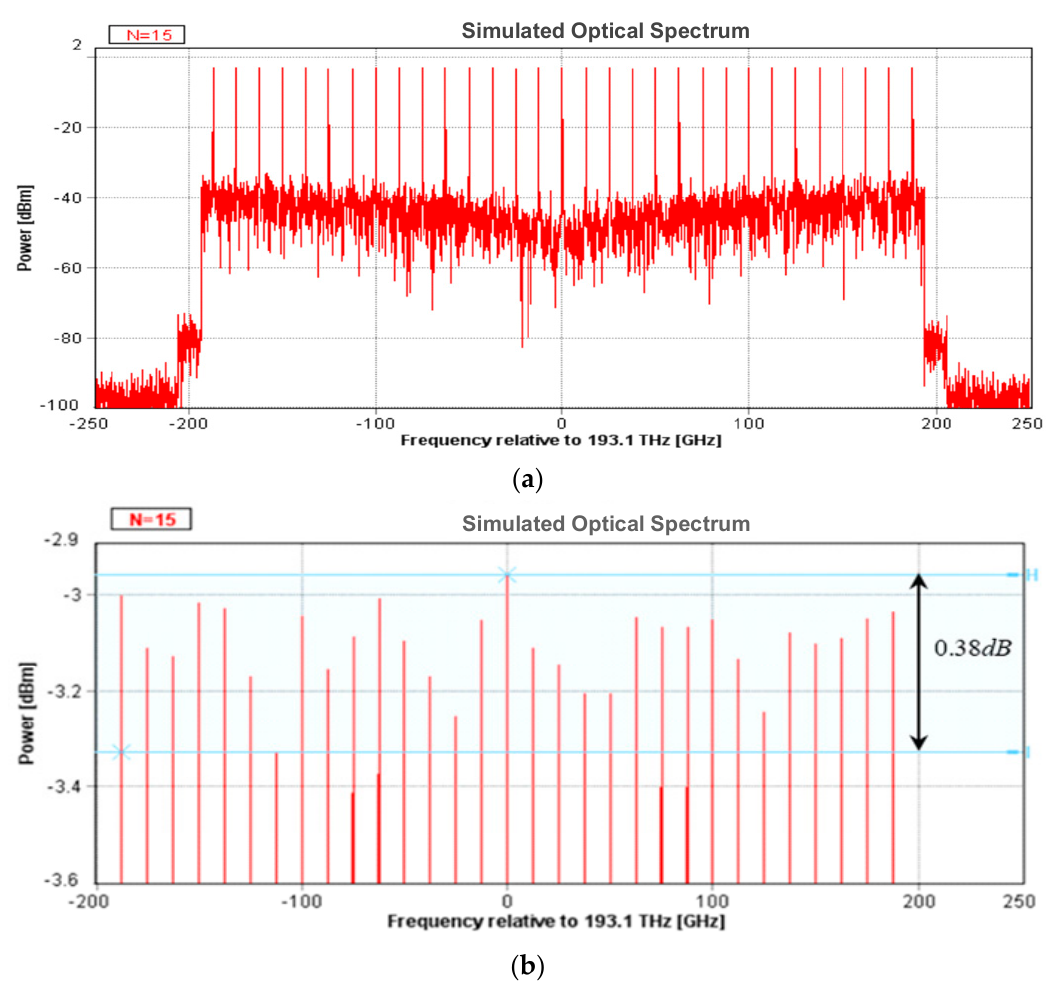
Figure 2. 31-line optical frequency comb and the measurement of flatness; ( a ) 31-line optical frequency comb; ( b ) flatness measurement of the 31-line optical frequency comb.